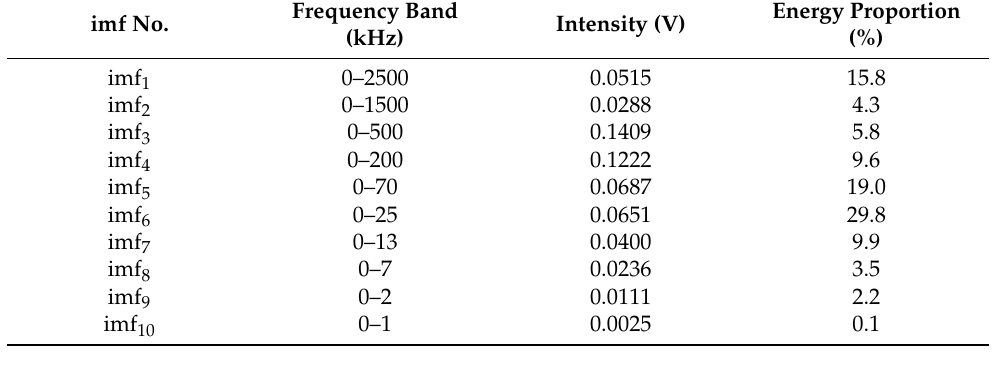
Figure 15. EMD results: ( a ) decomposed components of EMR waveform; ( b ) Fourier spectra of de- composed components. Table 2. Parameters of the components obtained by EMD. Table 2. Parameters of the components obtained by EMD.